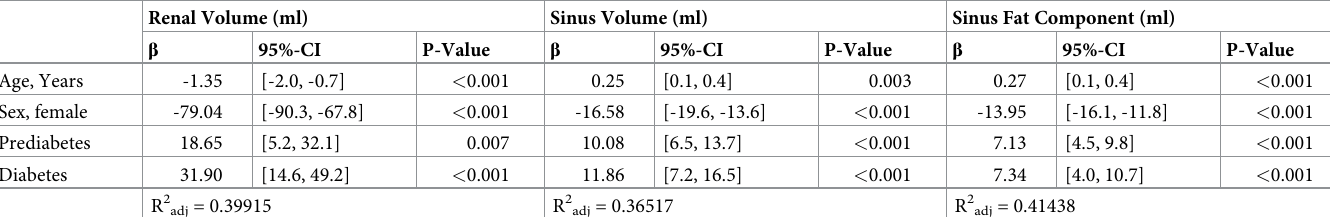
Table 2. Regression model with adjustments for age, gender and glycemic